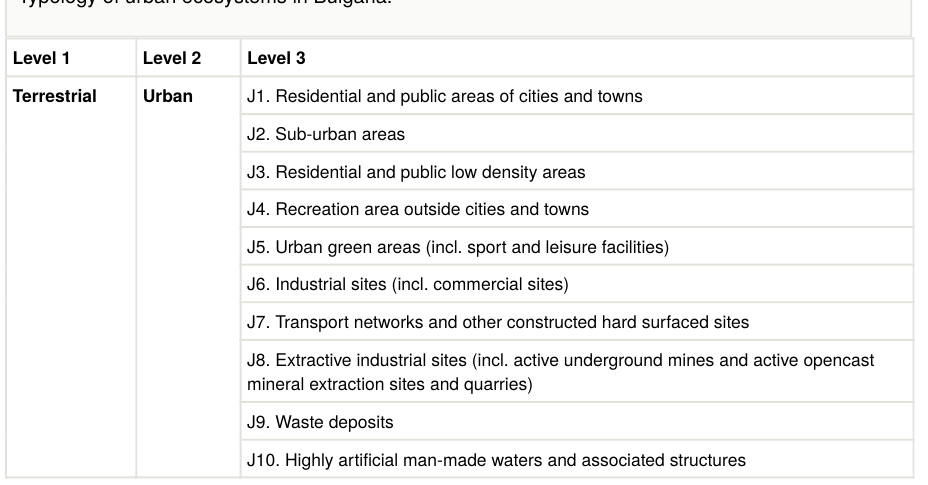
Typology of urban ecosystems in